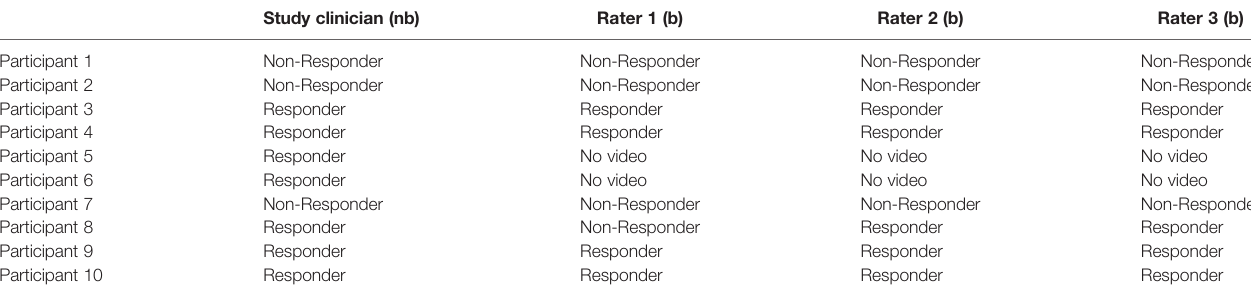
TABLE 3 | Assignment of the participants to responder/non-responder of the different raters [blinded (b) and non-blinded (nb)].